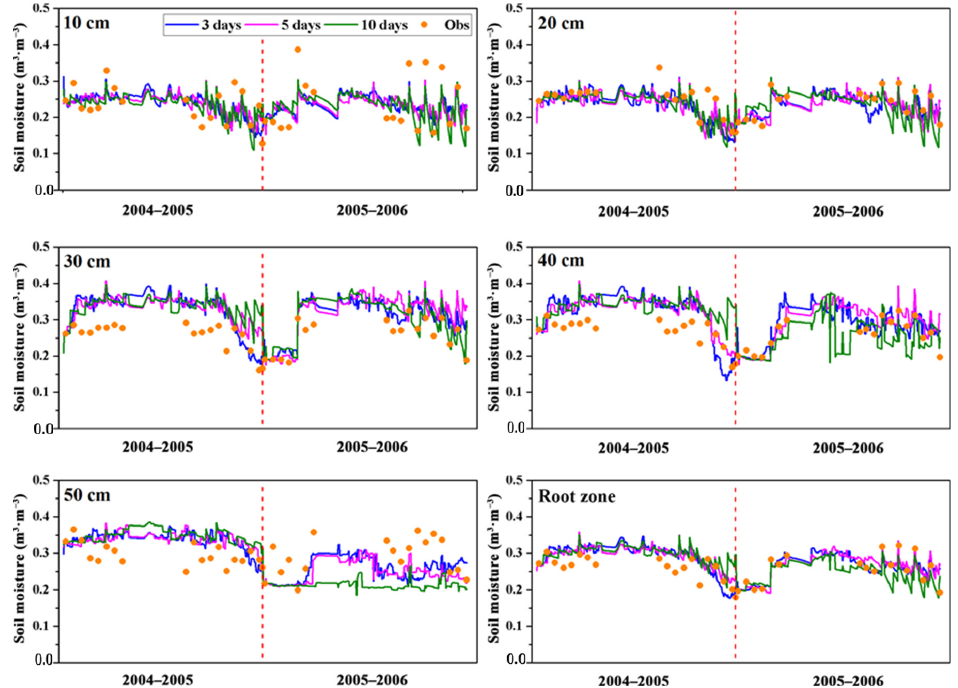
Figure 8. Soil moisture assimilation estimates with the observation intervals of three, five, and ten days at different soil depths during the growing seasons of 2004–2005 and 2005–2006.